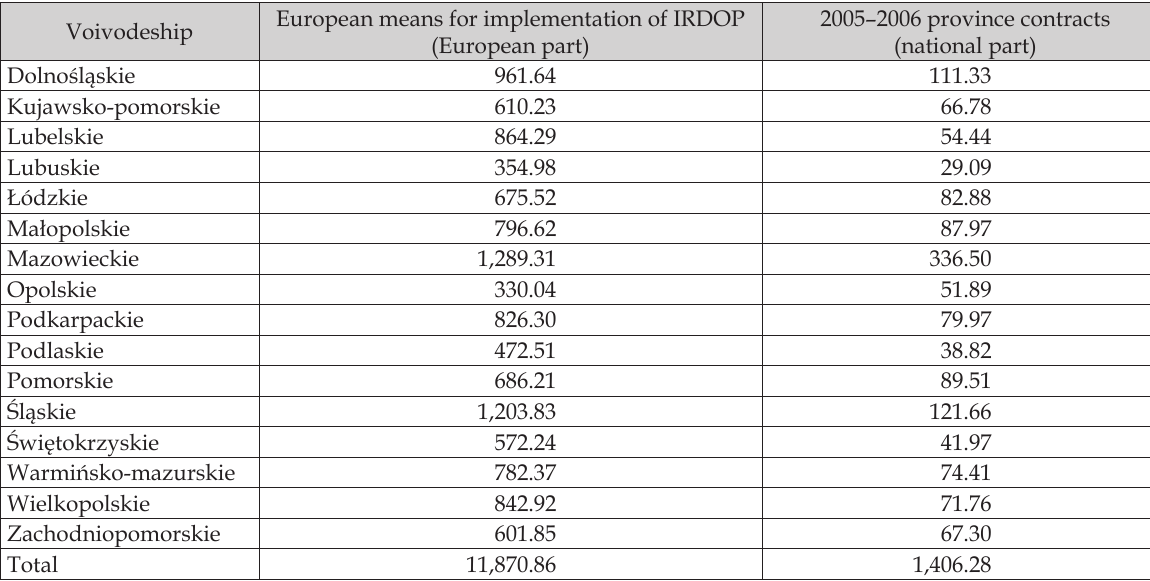
Table 2. Means spent under province contracts in the first years of the Polish membership in the European Union (2004–2006) (in million PLN).